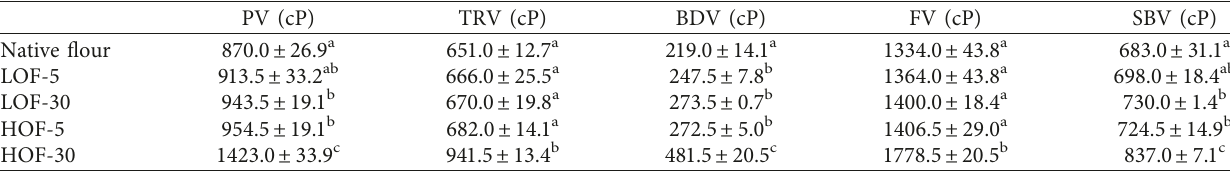
Table 1: The pasting parameters of native and ozone-treated wheat flours †